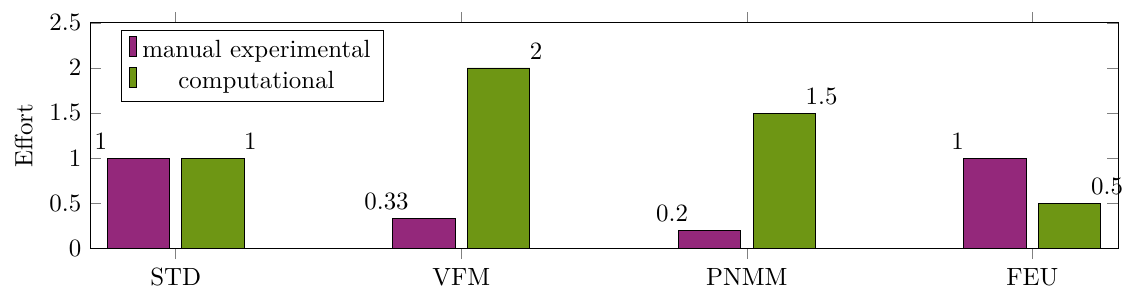
Figure 11. Manual experimental and computational effort of virtual fields method (VMF), parallel network material model (PNMM) and finite element updating (FEU) normalized to the standard method